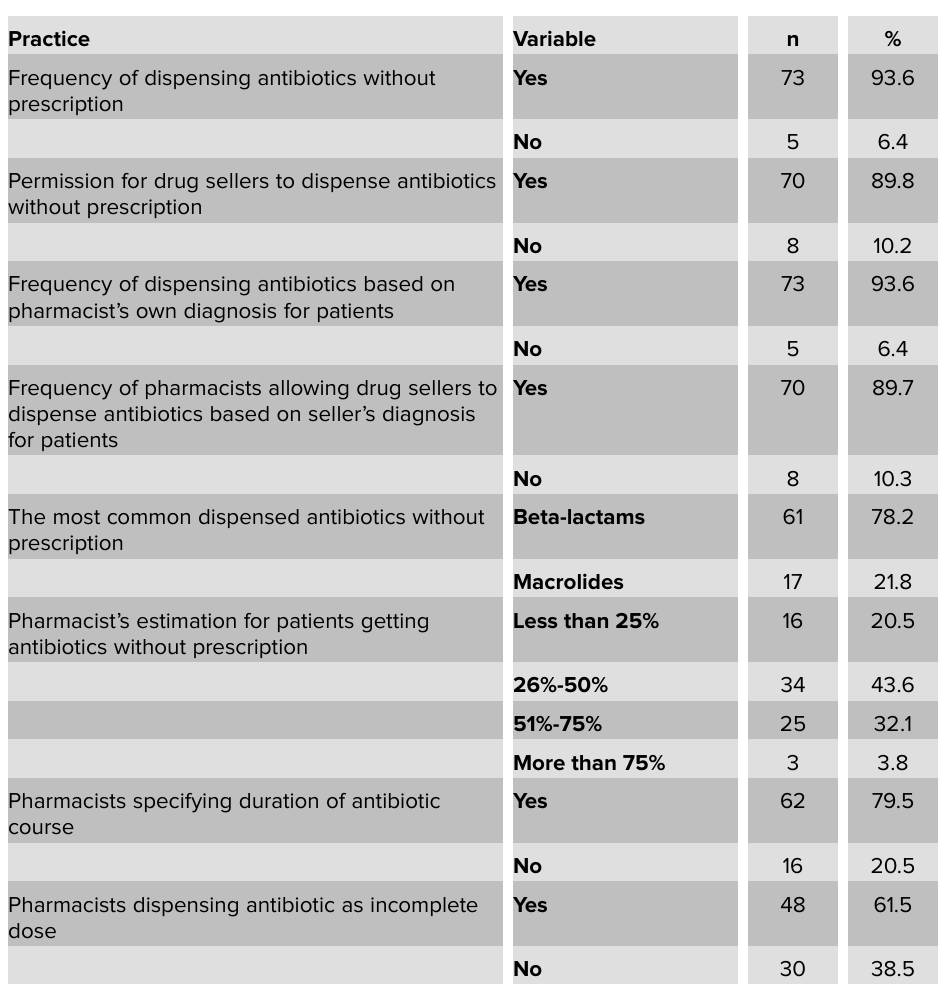
Table 3: The common practices of pharmacists towards antibiotic dispensing in River Nile State, Sudan 2014